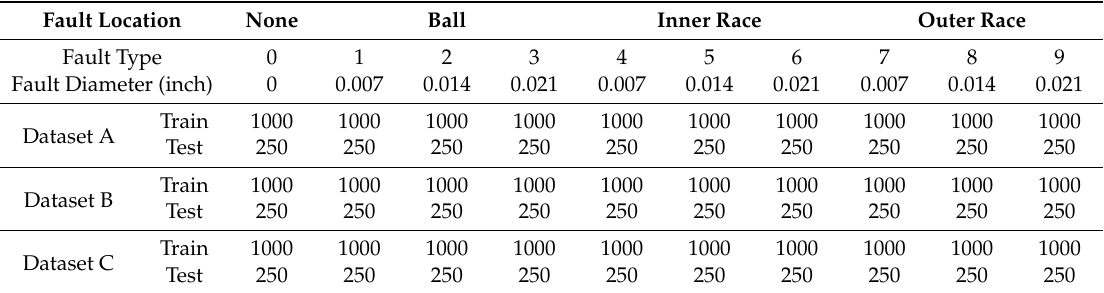
Table 3. Description of rolling element bearing